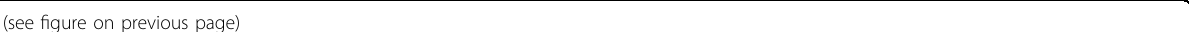
Fig. 1 Structural and functional effects of mutations in the S protein of the SARS-CoV-2 B.1.1.7 (Alpha) variant on human lung cells. a Schematic representation of the B.1.1.7 SARS-CoV-2 S protein with ten natural mutations. The S1 subunit contains mainly an N-terminal domain (NTD), a receptor-binding domain (RBD), and subdomains 1 and 2 (SD1 and SD2). The S2 subunit contains a fusion peptide (FP), fusion peptide proximal region (FPPR), heptad repeats 1 and 2 (HR1 and HR2), a central helix (CH), a connector domain (CD), a transmembrane domain (TM) and a cytoplasmic tail (CT). b Overall structure of SARS-CoV-2 B.1.1.7 S in the 1-RBD-up state, indicating the natural mutations. c Overall structure of the SARS-CoV-2 B.1.1.7 S-ACE2 complex. The interface between the RBD and ACE2 is magni fi ed to compare the structures of WT S-ACE2 (gray) and N501Y S-ACE2 (light blue). d The N501Y mutation site in the three structures mentioned in ( c ). e The A570D, D614G, P681H, T716I, S982A and D1118H mutation sites in the three structures mentioned in ( c ). f Structural model of furin with the cleavage sites in the SARS-CoV-2 and B.1.1.7 variants. g Representative images of cell – cell fusion between 293T/SARS-CoV-2(WT)/EGFP, 293T/SARS-CoV-2(D614G)/EGFP, 293T/SARS- CoV-2(B.1.1.7)/EGFP effector cells and target cells (Calu-3) after coculture for 6 h. Scale bars, 400 µm. h Western blot analysis of S protein expression in effector cells. i – m Statistical analysis of fusion rates mediated by the WT, D614G, and B.1.1.7 S protein after coculture for 1 h ( i ), 2 h ( j ), 3 h ( k ), 4 h ( l ), and 12 h ( m ). Asterisks indicate signi fi cant differences. * P < 0.05, ** P < 0.01, *** P < 0.001. NS , not signi fi